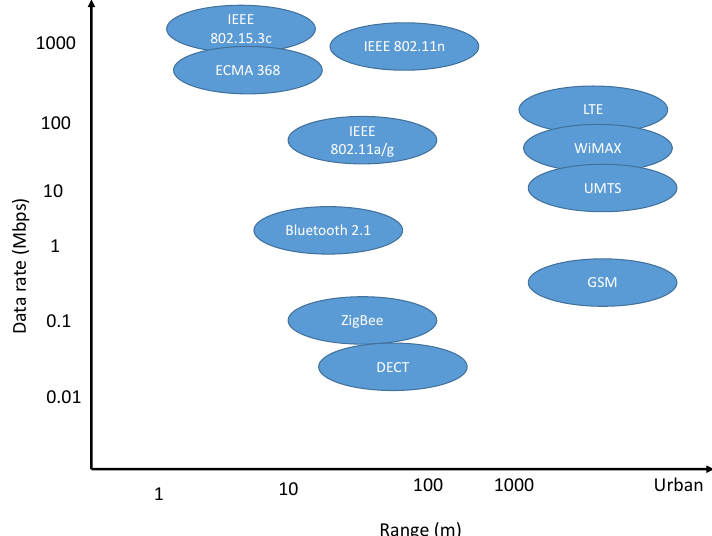
Figure 3. Data rate vs. range comparison for different wireless commercial standards L0 HLA.